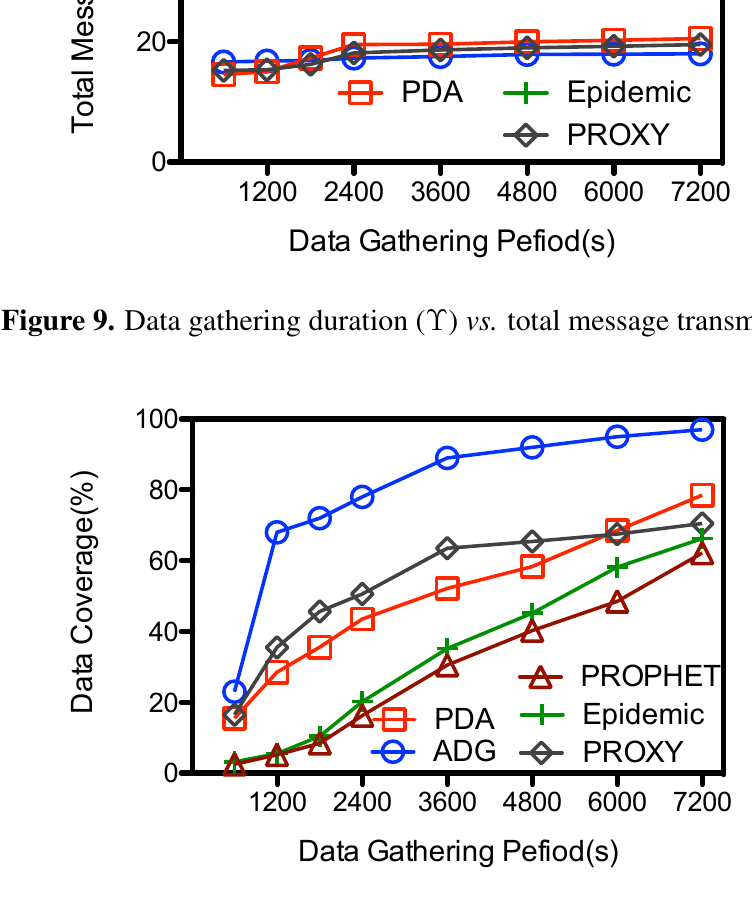
Figure 10. Data gathering duration ( Υ ) vs. data